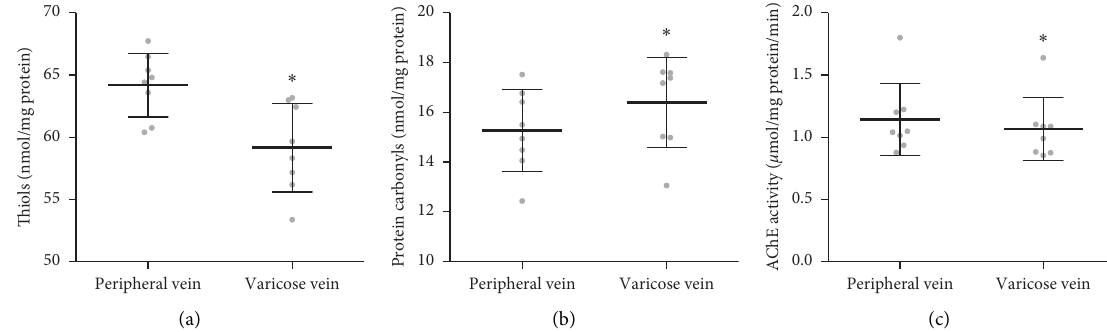
Figure 4: The levels of free thiols (a), protein carbonyl compounds (b), and acetylcholinesterase activity (c) in the erythrocyte membrane obtained from a peripheral vein and a varicose vein. Data are shown as mean ± range of standard deviation, n � 8. ∗ p < 0 . 05 is the significant difference.